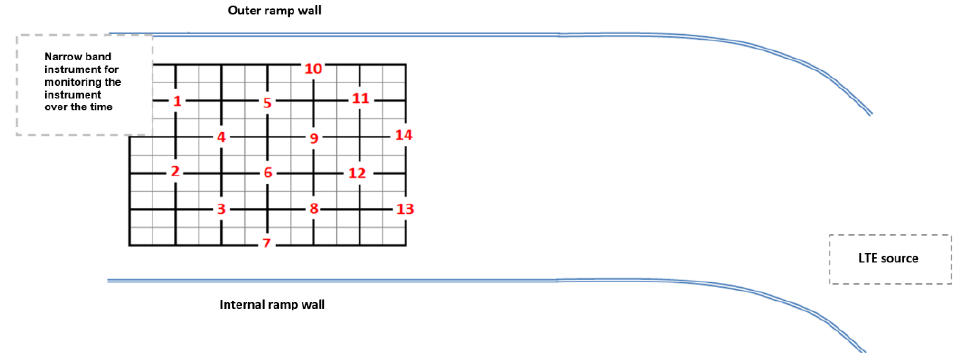
Figure 3. The scheme of the positions in the site (not in scale).